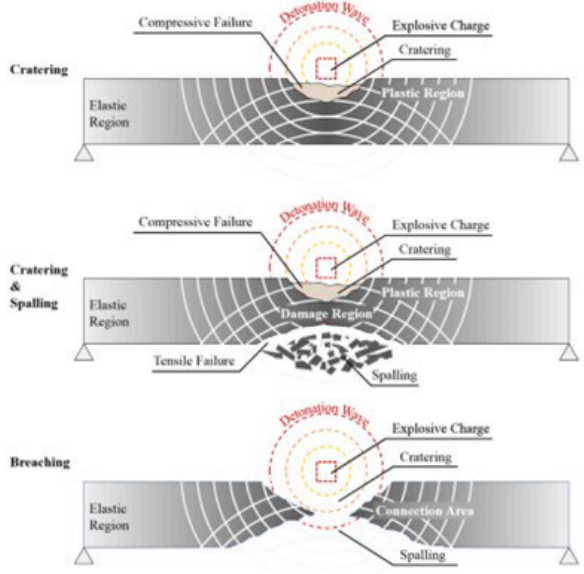
Figure 1- Cratering, spalling and breaching damage of concrete structures exposed to contact explosion